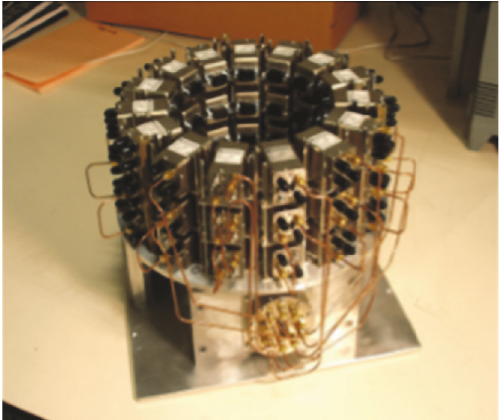
Figure 22: The completed 60-way TX/RX electromechanical switching interface at Bristol University. Taken from [26]; copyright EurAAP; used with